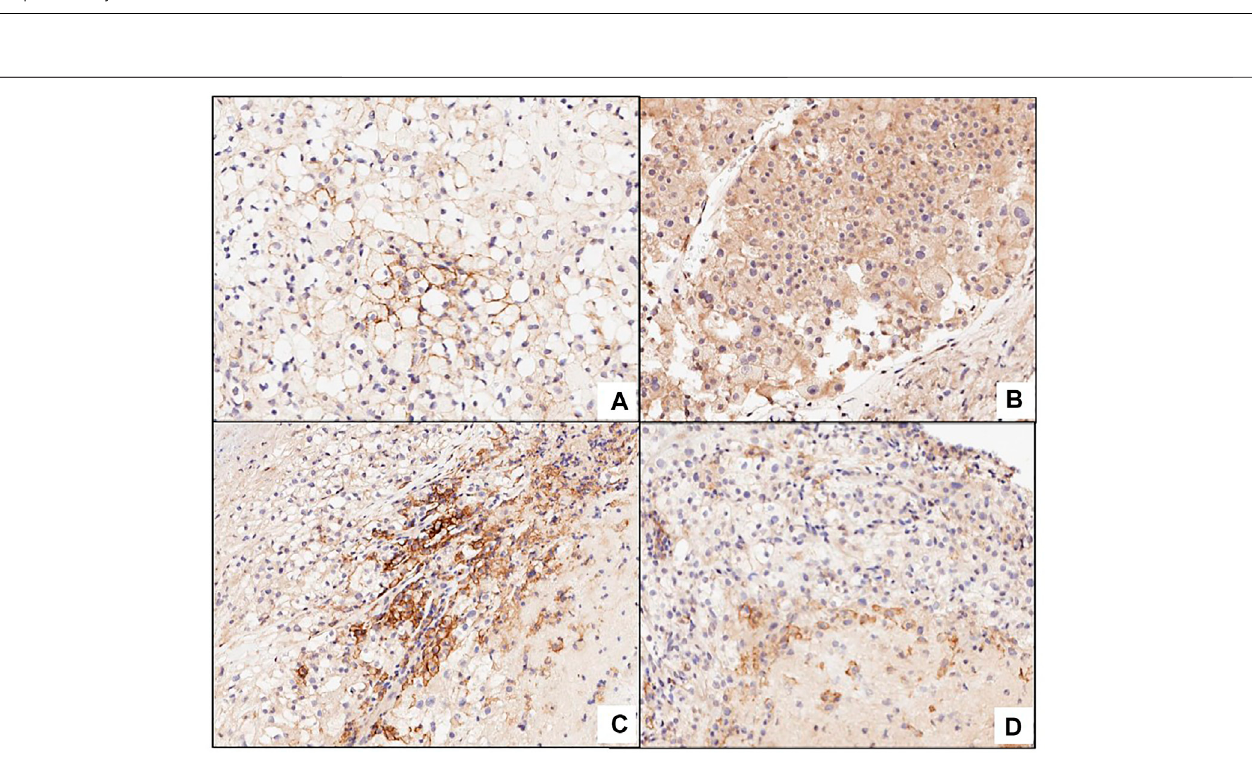
Frontiers in Molecular Biosciences |